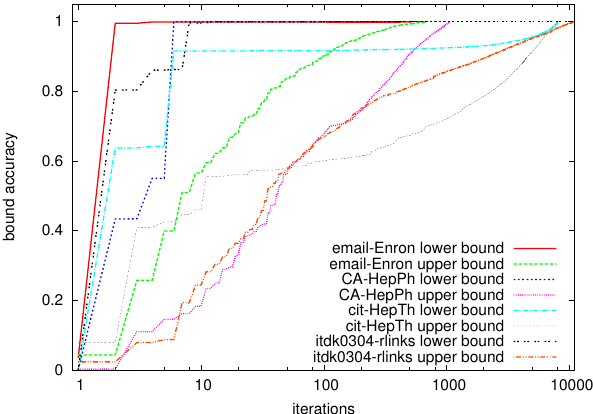
Figure 7. Bound accuracy vs . number of iterations for Algorithm